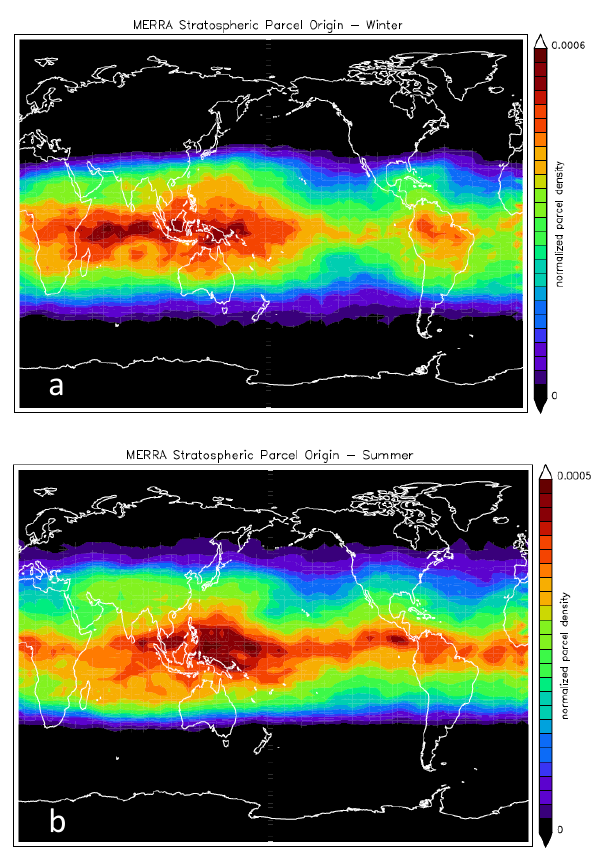
Fig. 8. Seasonal maps for TTL parcels that end up in the strato- sphere (parcel origin). (a) , Density map for 360K parcels initiated during winter (DJF); (b) , summer